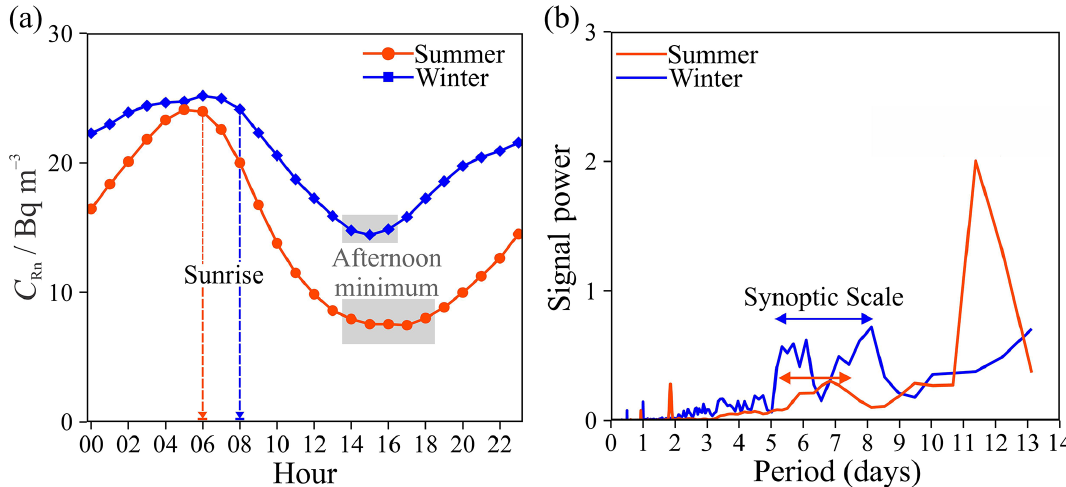
Figure 2. (a) Summer and winter diurnal composite hourly radon concentration and (b) spectral analysis of the LjB hourly atmospheric pressure data for summer and winter. Table 2. Air temperature correlation coefficients between each of the eight ground-based automatic weather stations in spring, summer, autumn, and